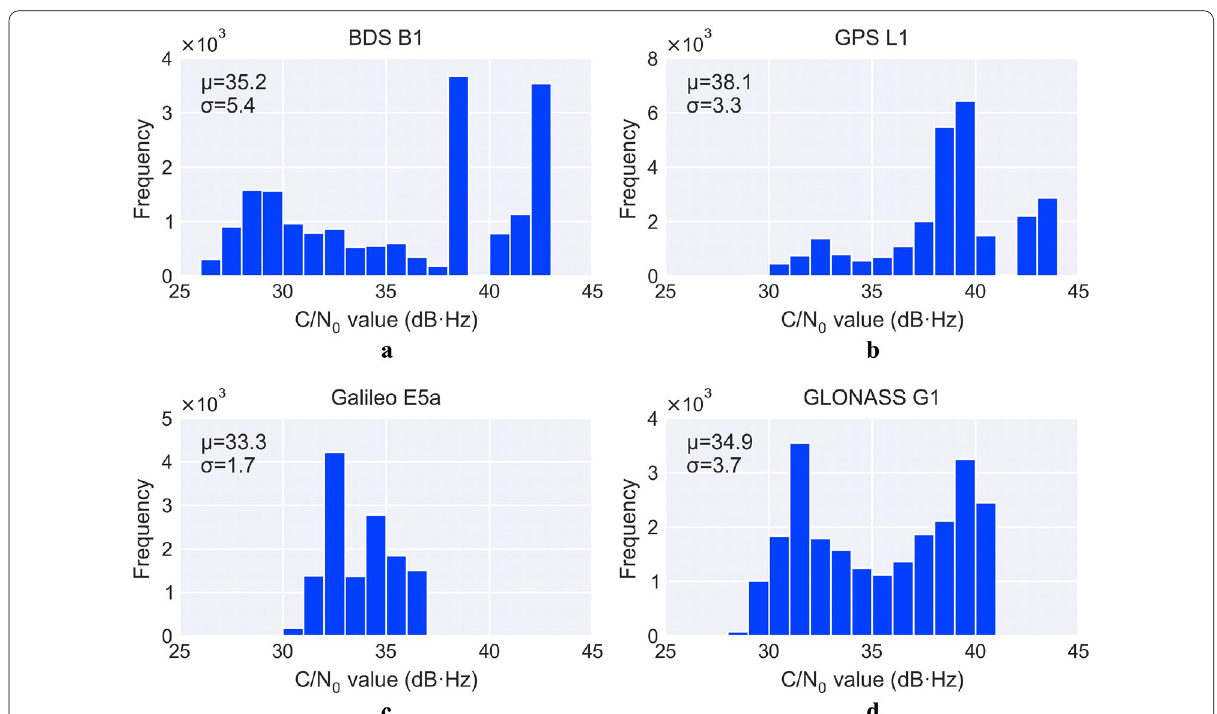
Fig. 9 Histogram and statistics of the C/N0 measurements of a BDS, b GPS, c Galileo and d GLONASS satellites at elevation angles above